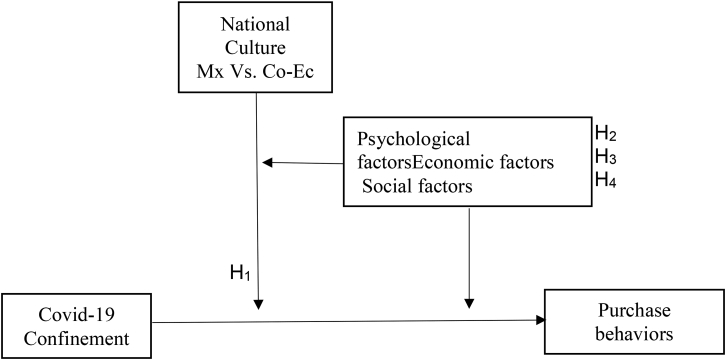
Hypothetical Model. Source: Own elaboration.